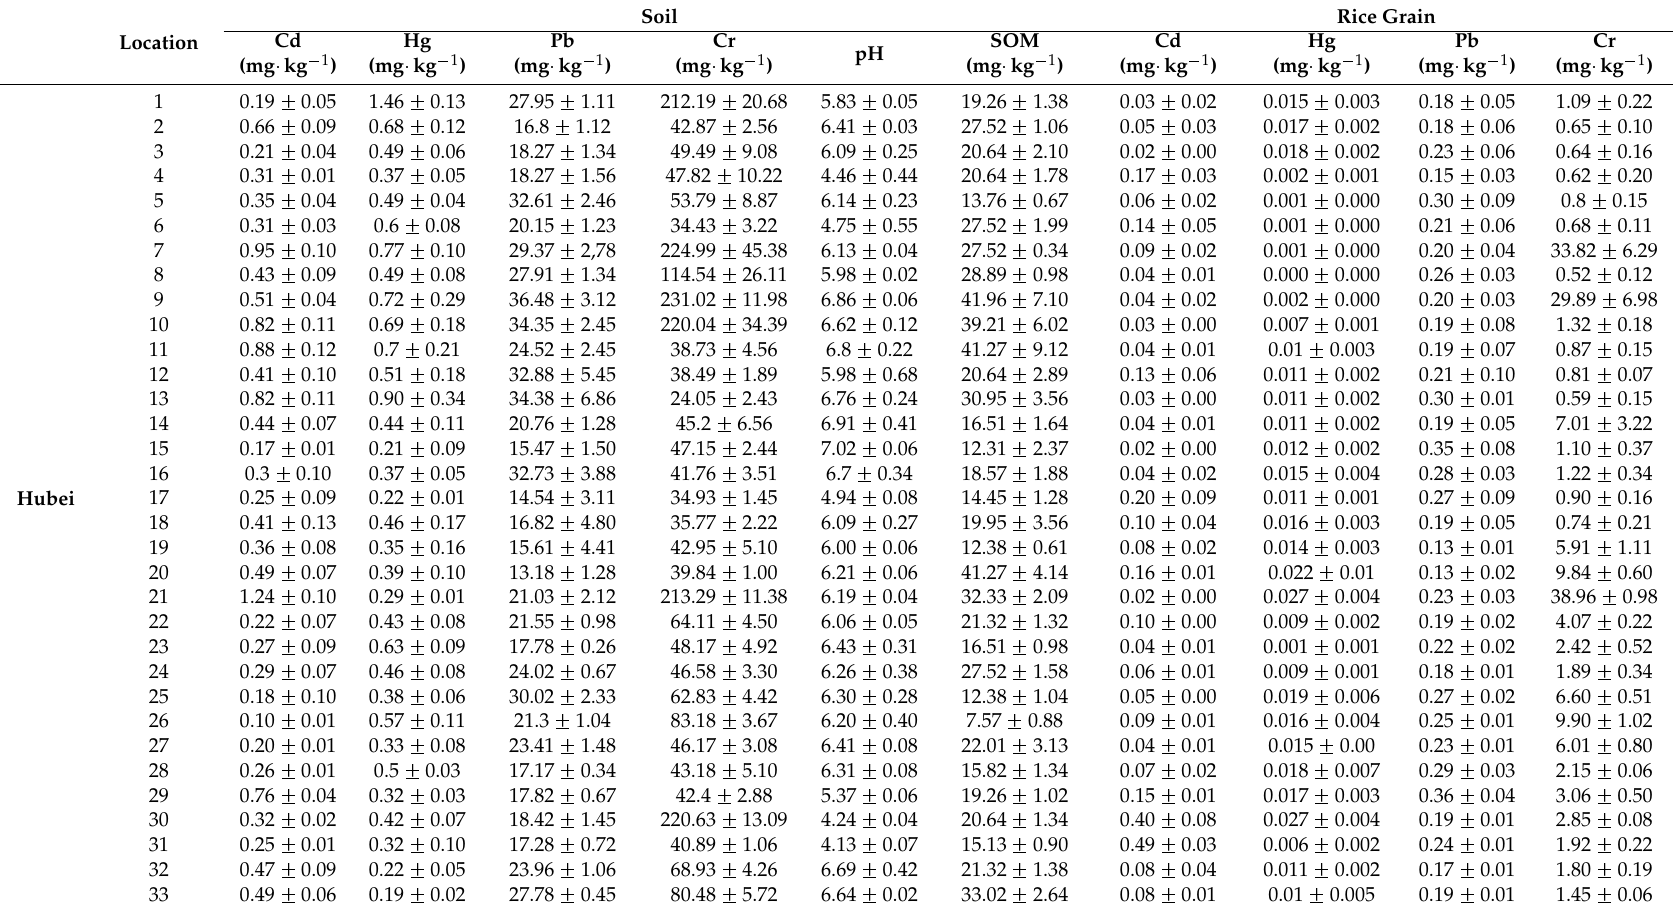
Soil Rice Grain